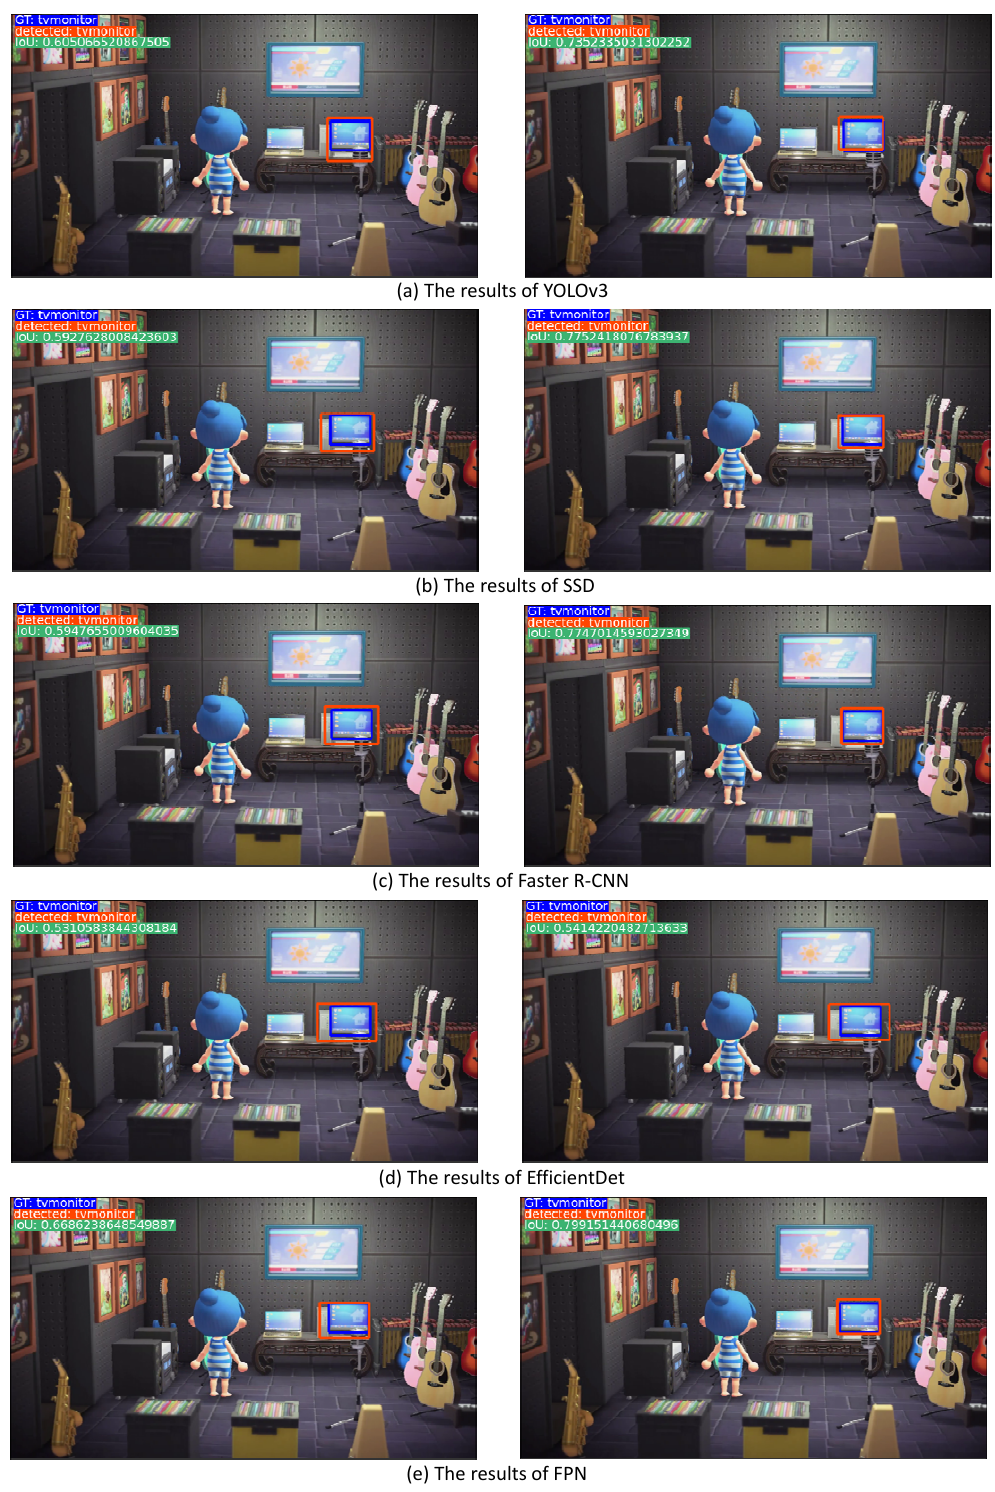
Figure A3. Comparison of the bounding box detection on game Animal Crossing . The left column is the result from the models trained by PASCAL VOC and the right column is the result from the models trained by PASCAL VOC and game